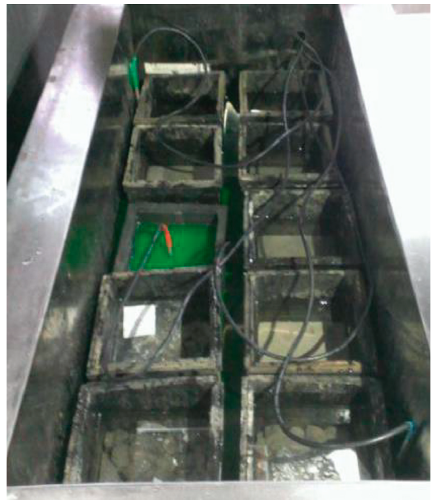
Figure 11: Frost resistance